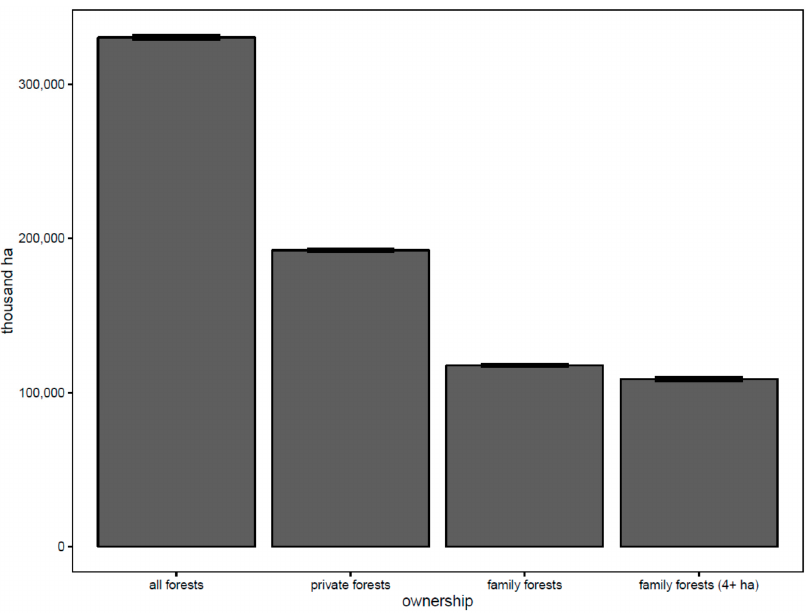
Figure 1. Estimated area of forest and woodland by ownership category, United States, 2011–2013. Error bars represent two standard errors. USDA Forest Service’s National Woodland Owner Survey (NWOS), 2016. Source: [1].